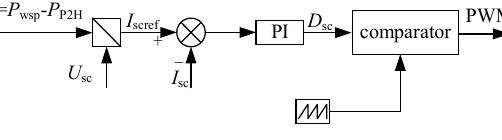
Figure 8. Control diagram of SCESS.